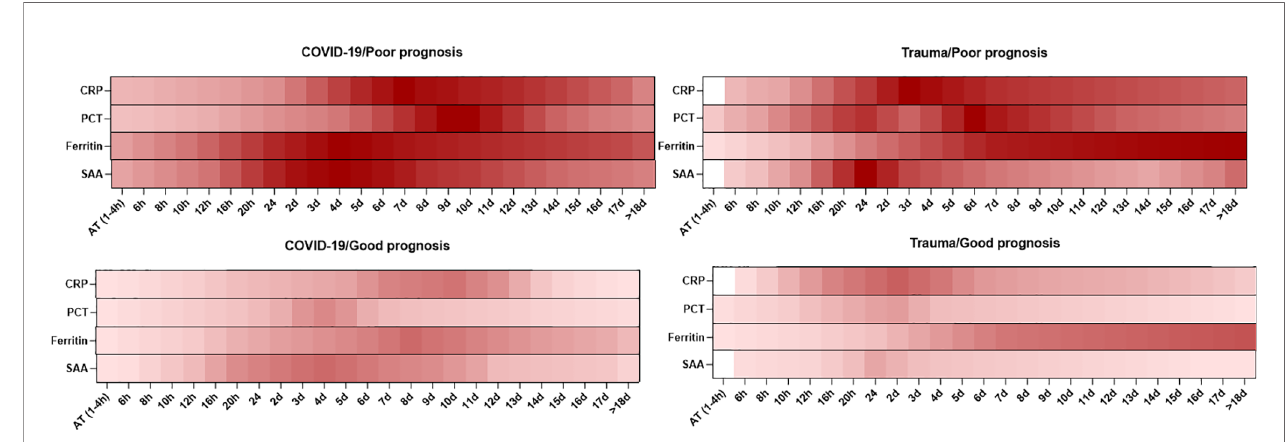
FIGURE 1 | Association between the kinetics of changes in serum levels of in fl ammatory mediators with prognosis in patients with COVID-19 and trauma. The heat map represents the kinetics of changes in serum CRP (30, 32, 33, 37, 80), PCT (30, 33, 38, 51 – 53, 55), ferritin (33, 68) and SAA (73, 75, 76, 78) levels during 18 days after admission in COVID-19 and trauma patients associated with poor and good prognoses. COVID-19 patients with an increased risk of mortality, MOF, severe-to-critical forms of the disease, intensive care unit admission, and/or hospitalization are de fi ned as a poor prognosis for the disease. Conversely, patients with the opposite are de fi ned as having a good prognosis for the COVID-19. AT, admission time; CRP, c-reactive protein; d, day; h, hour; MOF, multiple organ failure; PCT, procalcitonin; SAA, serum amyloid A.